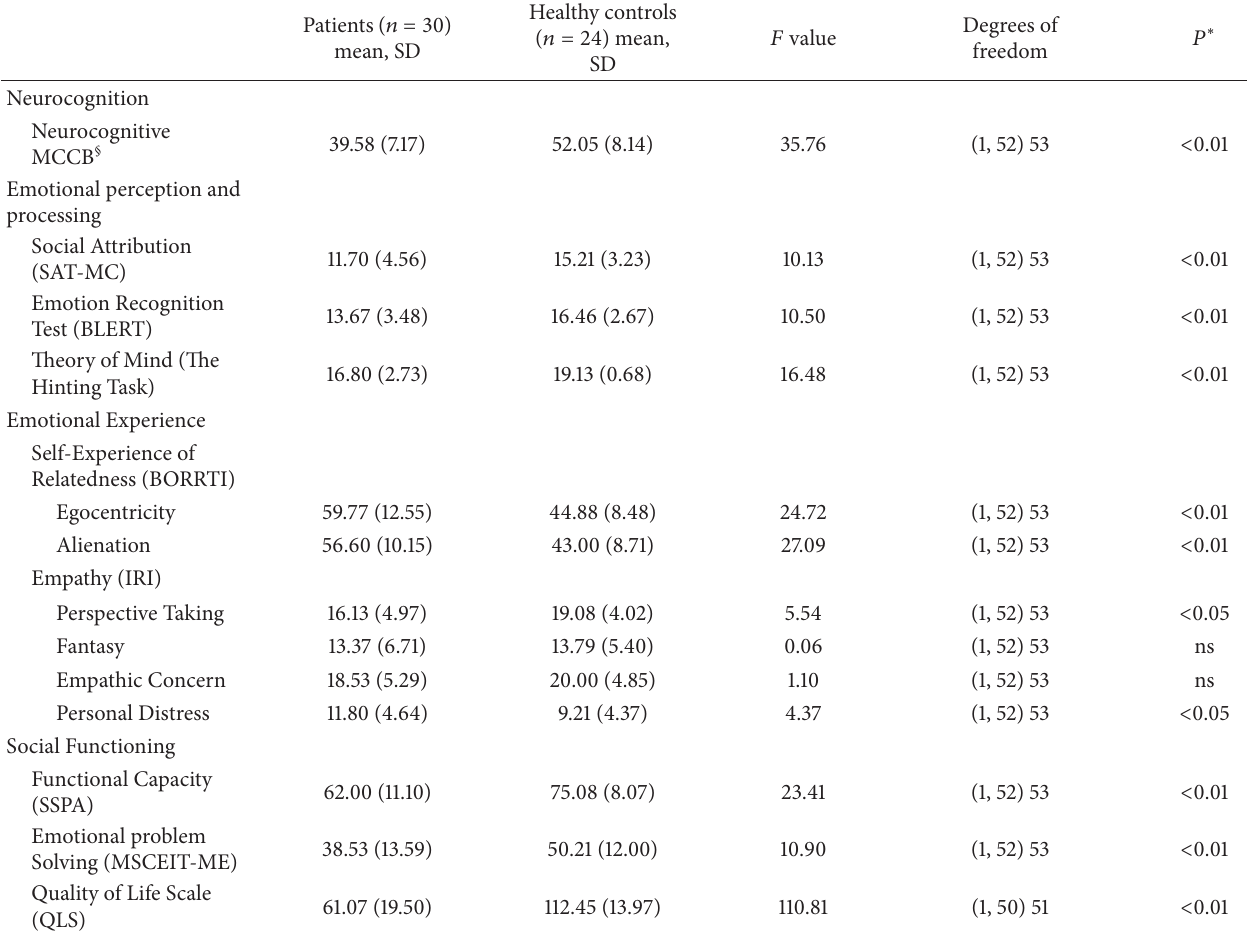
Table 2: Social cognitive and neurocognitive measures